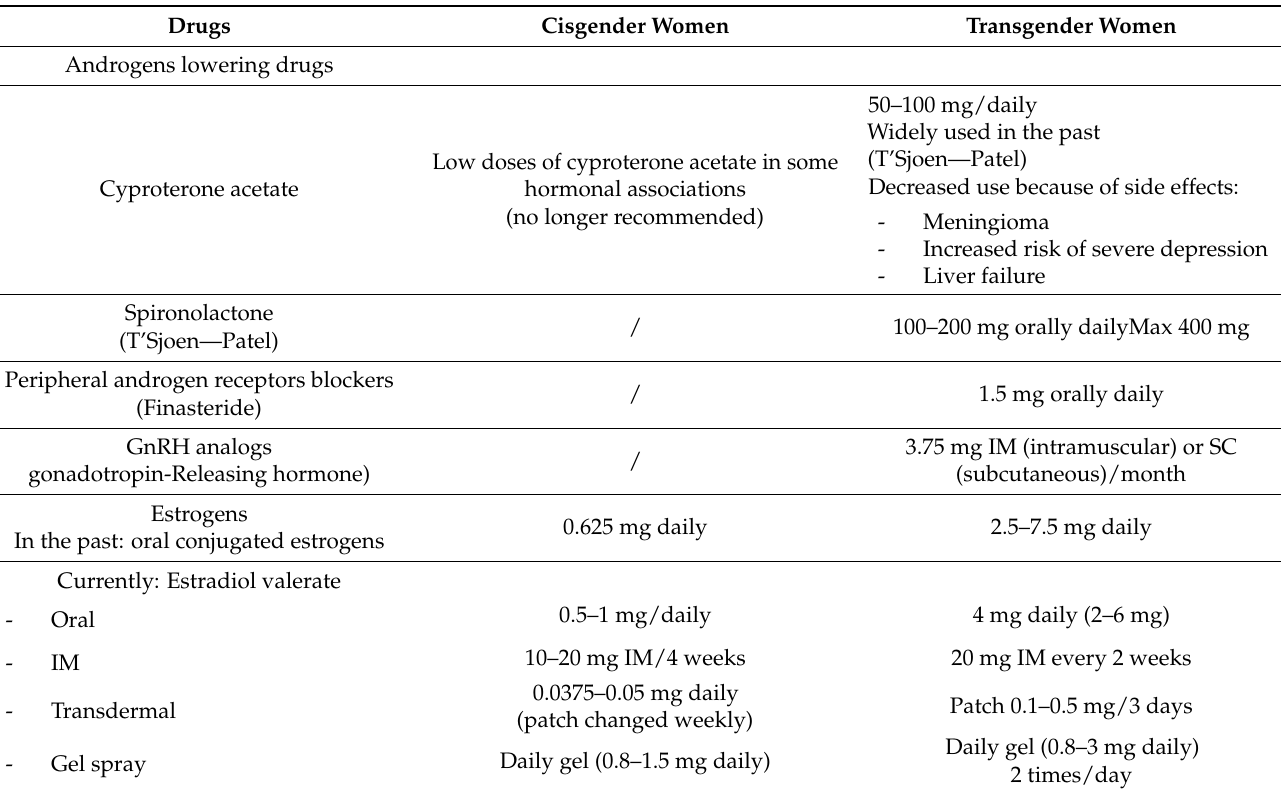
Table 1. Drugs and dosages of HRT (hormone replacement therapy) compounds in cisgender women and GAHT (gender-affirming hormone therapy) in transgender